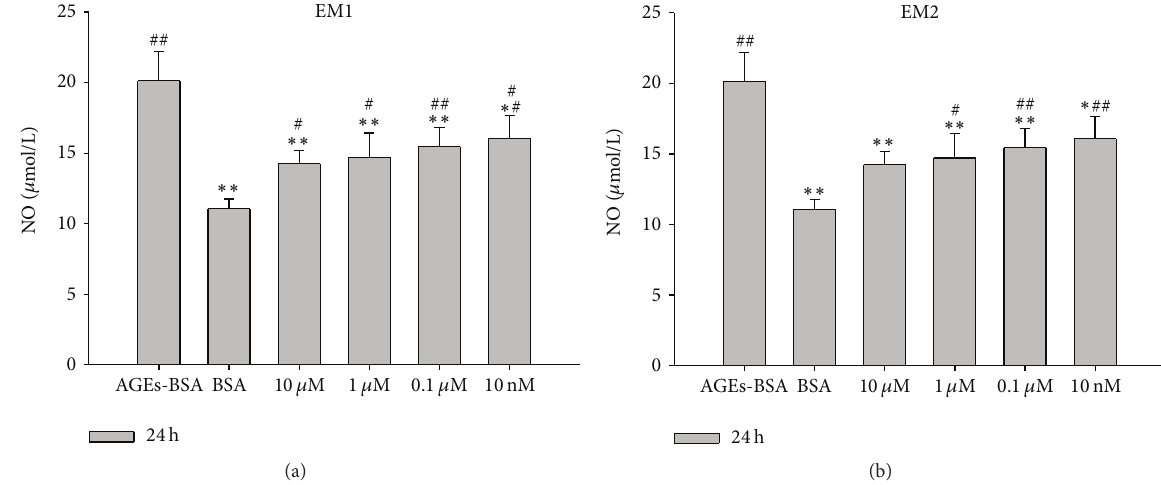
Figure 3: Effect of EM1, EM2 on NO concentration determined by Griess reaction test in HUVEC. Each data is expressed as mean ± SD ( 𝑛 = 3 ). ∗ 𝑃 < 0.05, ∗∗ 𝑃 < 0.005 versus AGEs-BSA group, # 𝑃 < 0.05, ## 𝑃 < 0.005 versus control (BSA)